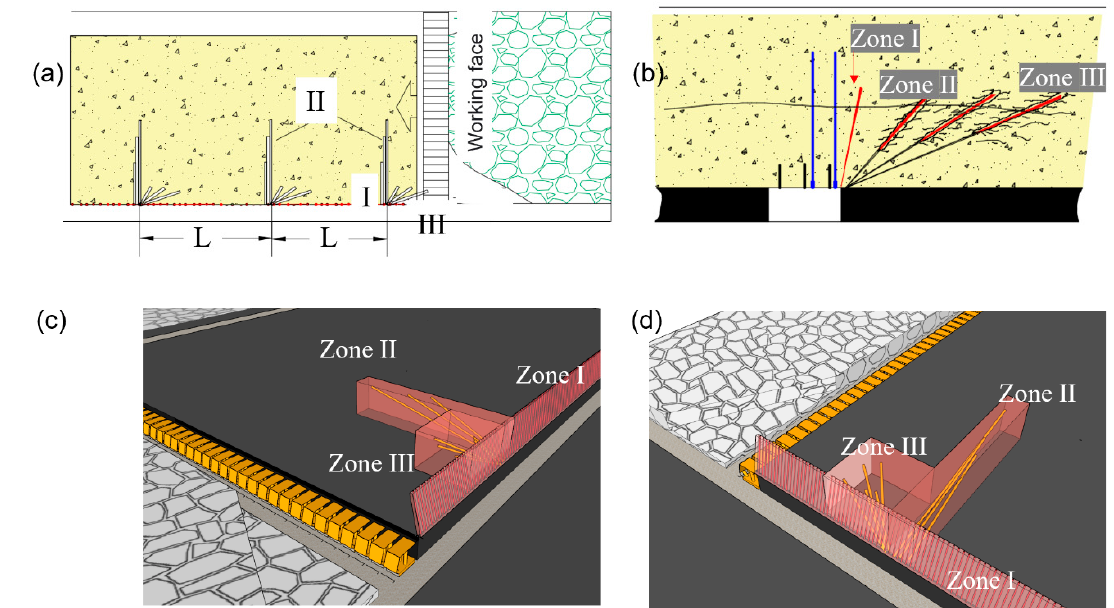
Figure 4. Three-Zone pre-split sketch design ( a ) Plan view of the design ( b ) Designed facade front view ( c ) View of 3D sketches from behind ( d ) View of 3D sketches from front.